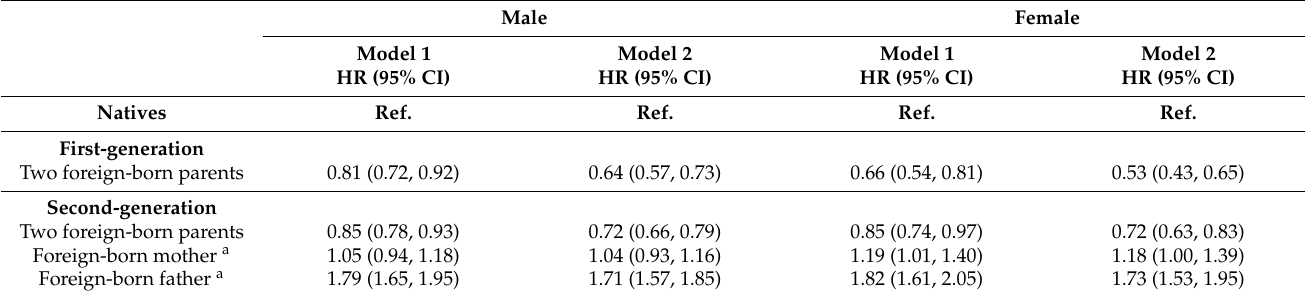
Table 3. Hazard ratios of Conduct Disorder among immigrants 4–16 years at baseline in Sweden,